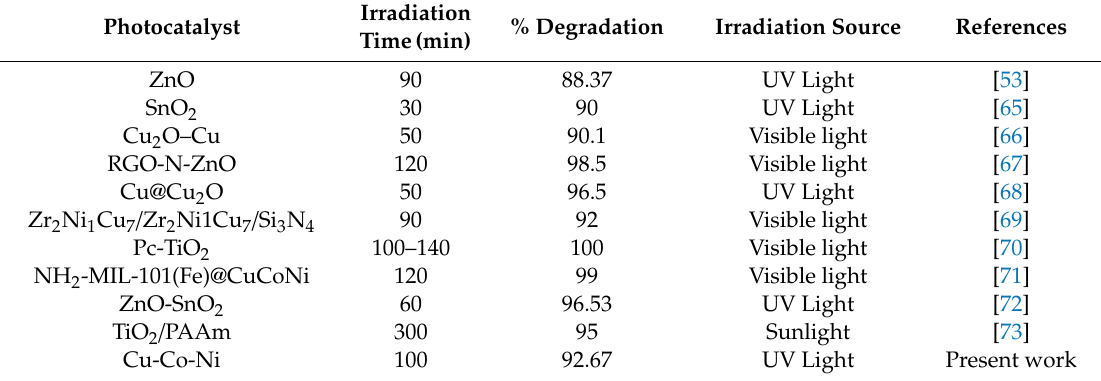
Table 2. Photocatalytic performance comparison of di ff erent photocatalysts for degradation of methylene